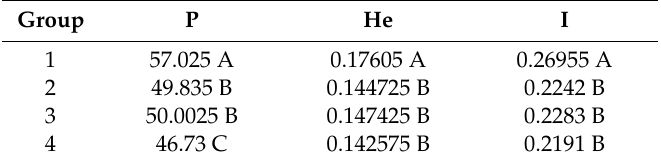
Table 3. Genetic diversity of bermudagrass of different latitudinal groups. Group P